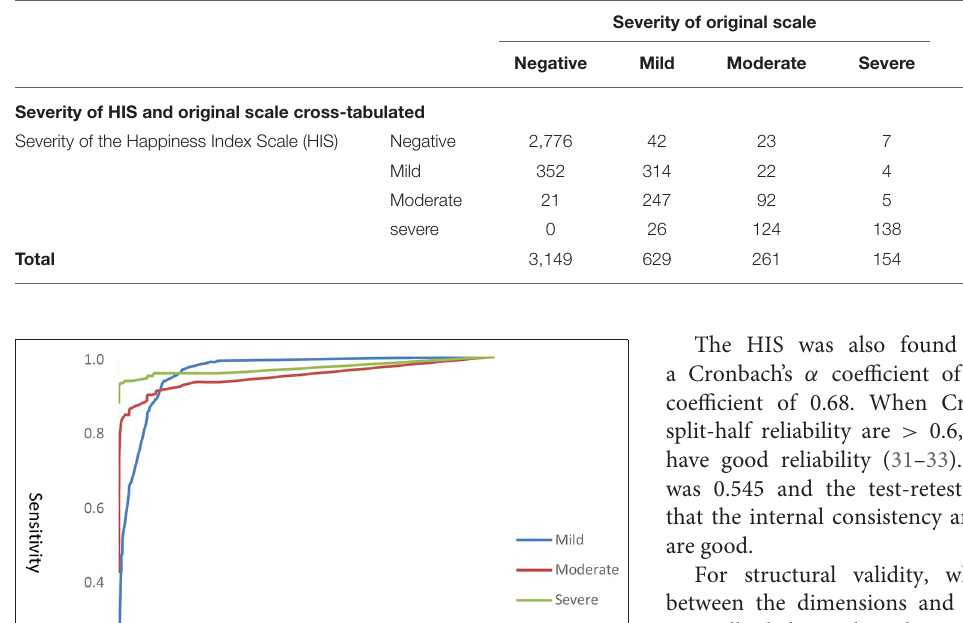
TABLE 4 | Kappa consistency test for the Happiness Index Scale (HIS).